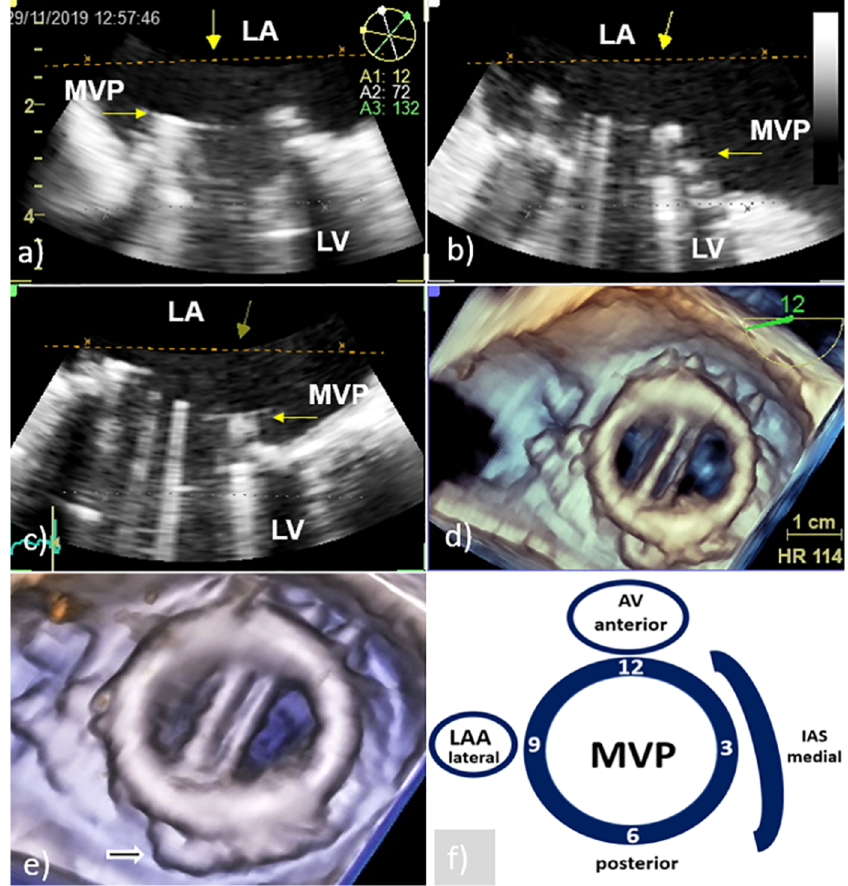
Figure 1. Transesophageal echocardiography of MVP: Presentation of the MVP in different two- dimensional planes needs careful mental reconstruction to translate the echo description into the anatomy ( a – c ); 3D TEE reconstruction allows realistic anatomic image of the MVP similar to the one the surgeon sees from the LA (surgeon’s view) ( d ); cropped and enlarged 3D TEE image allows better presentation of the MVP and surrounding structures (white arrow—residual tissue of posterior leaflet of native mitral valve) ( e ); schematic presentation of surgeon’s view (clockwise orienta- tion) with AV anteriorly at 12 o’clock position, IAS at the middle 3 o’clock position, and LAA at the lateral 9 o’clock position ( f ). AV—aortic valve; IAS—interatrial septum; LA—left atrium; LAA- left atrium appendage; LV—left ventricle; MVP—mitral valve prosthesis; and 3D TEE—three-dimen- sional echocardiography.